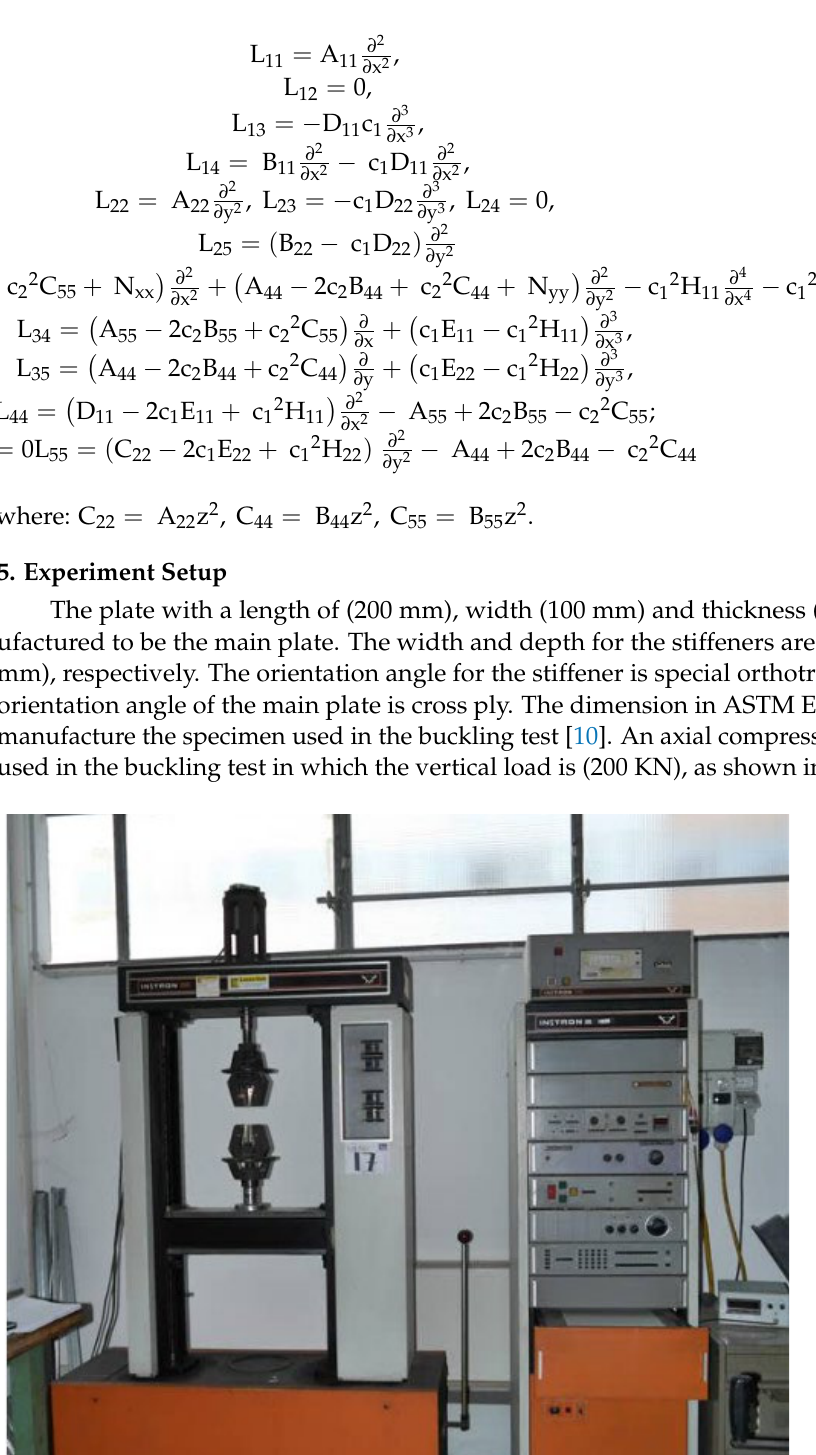
Figure 4. Rectangular plate without stiffeners.